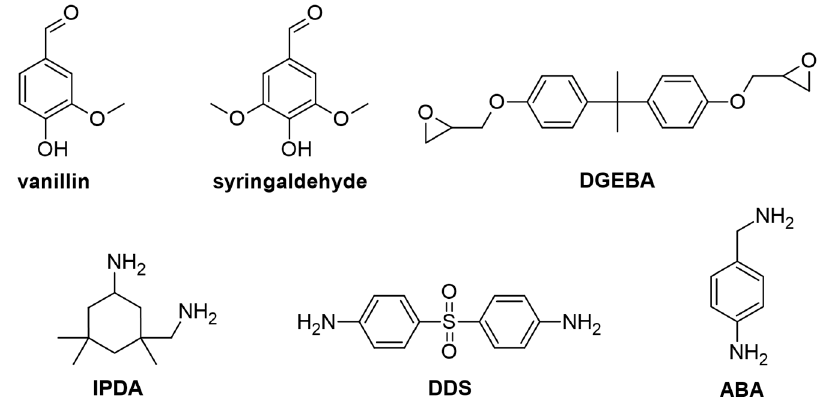
Figure 2. Starting materials (vanillin and syringaldehyde) for the synthesized amine hardeners and the reference epoxy resin components DGEBA, IPDA, and DDS, as well as ABA used for compara- tive purposes.